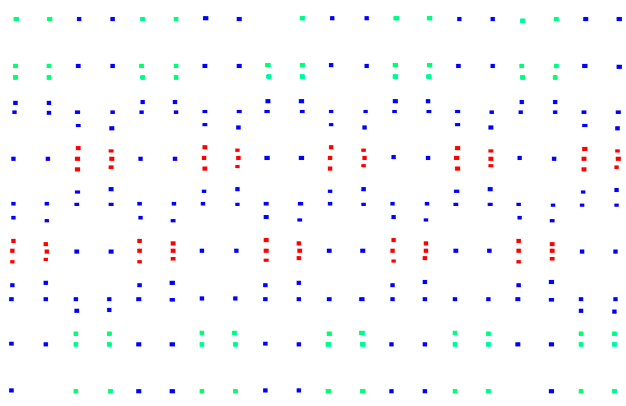
Figure 8. Classification results of bolt hole centers. Red, blue, and green dots represent the capped, adjacent, and standard blocks, respectively.